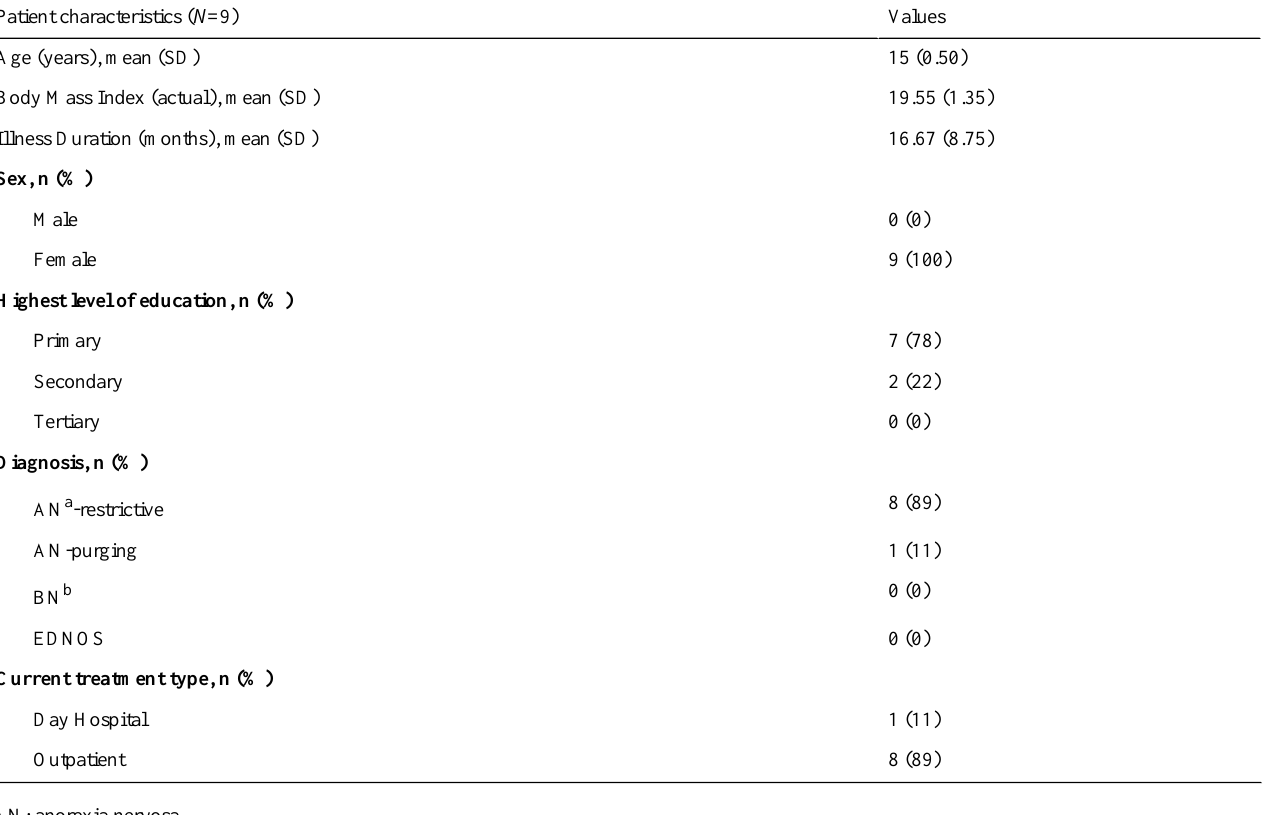
Table 1. Description of patients.